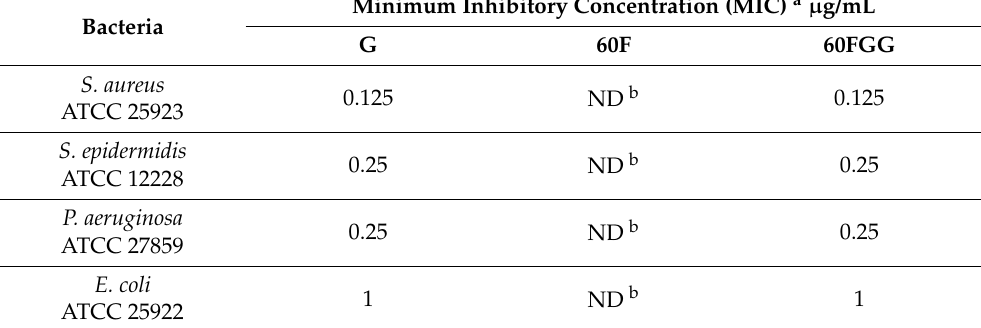
Table 1. MIC values for S. aureus , S. epidermidis , P. aeruginosa , and E. coli after 24 h incubation with aqueous solutions of gentamicin sulfate salt ( G ), C 60 fullerenol ( 60F ), and gentamicin functionalized C 60 fullerene ( 60FGG ).